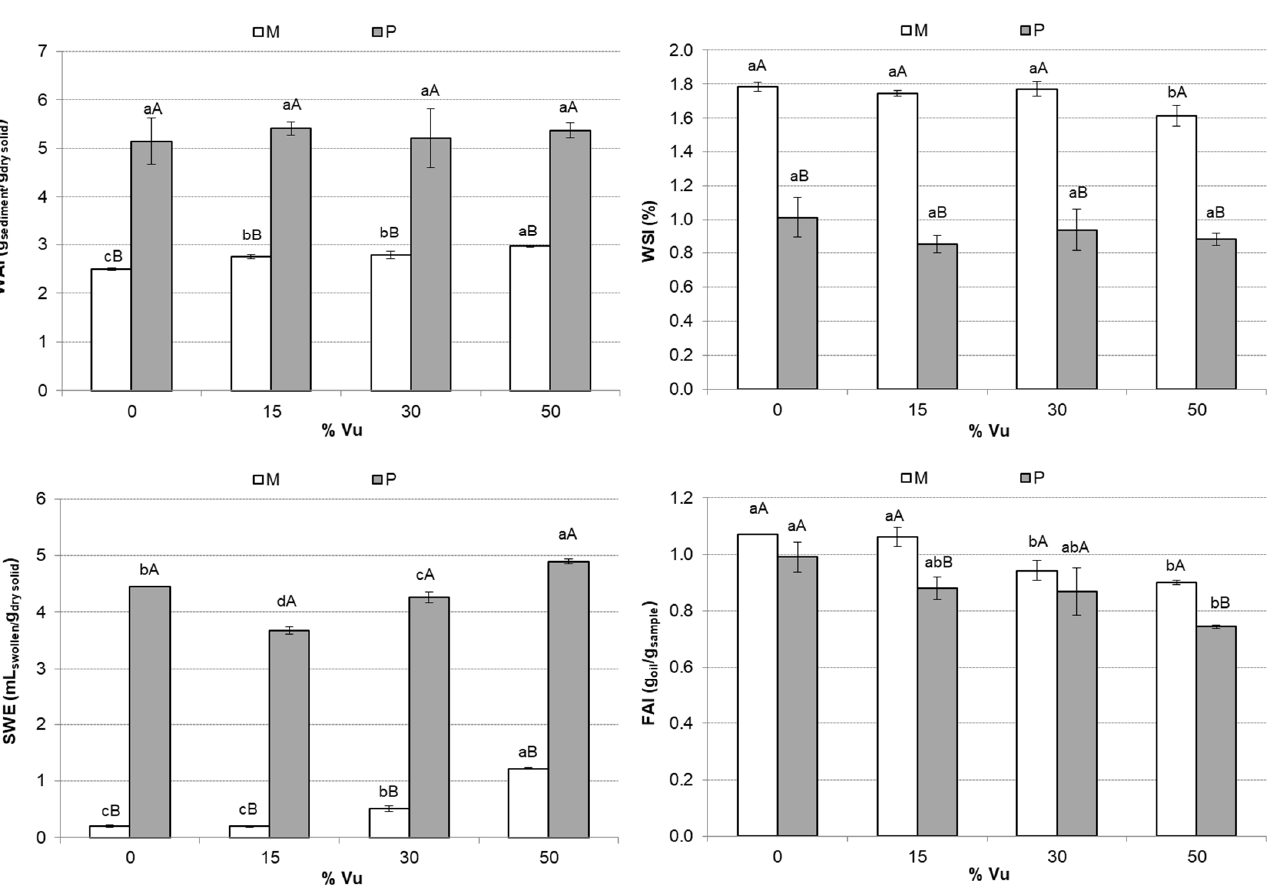
Figure 3. Mean values and standard deviation of the water absorption index (WAI), water solubility index (WSI), swelling index (SWE), and fat absorption index (FAI) of the mixtures (M) and powder (P). For each parameter, the same small letter indicates homogeneous groups established by ANOVA ( p < 0.05) by comparing the Vu percentages (0, 15, 30, and 50) in M or P. For each Vu percentage (0, 15, 30, and 50) and parameter, the same capital letter indicates homogeneous groups established by ANOVA ( p < 0.05) comparing M and